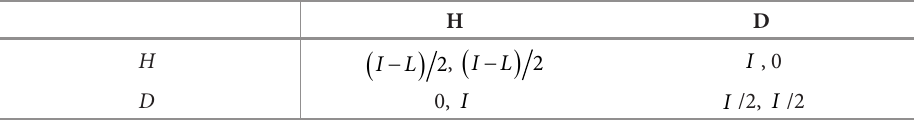
Table 1. Hawk-dove game and Nash